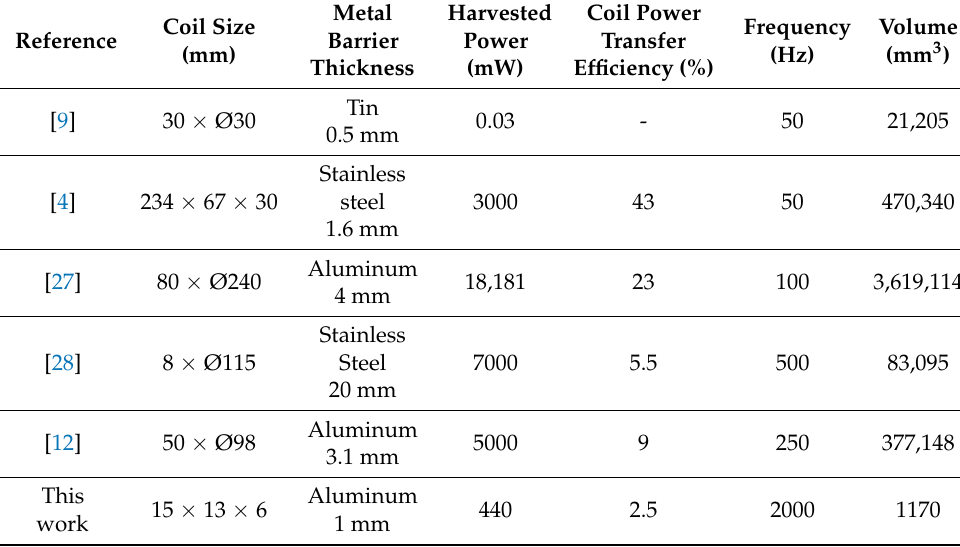
Table 2. Survey of similar works on energy and communications through aluminum and stainless steel.